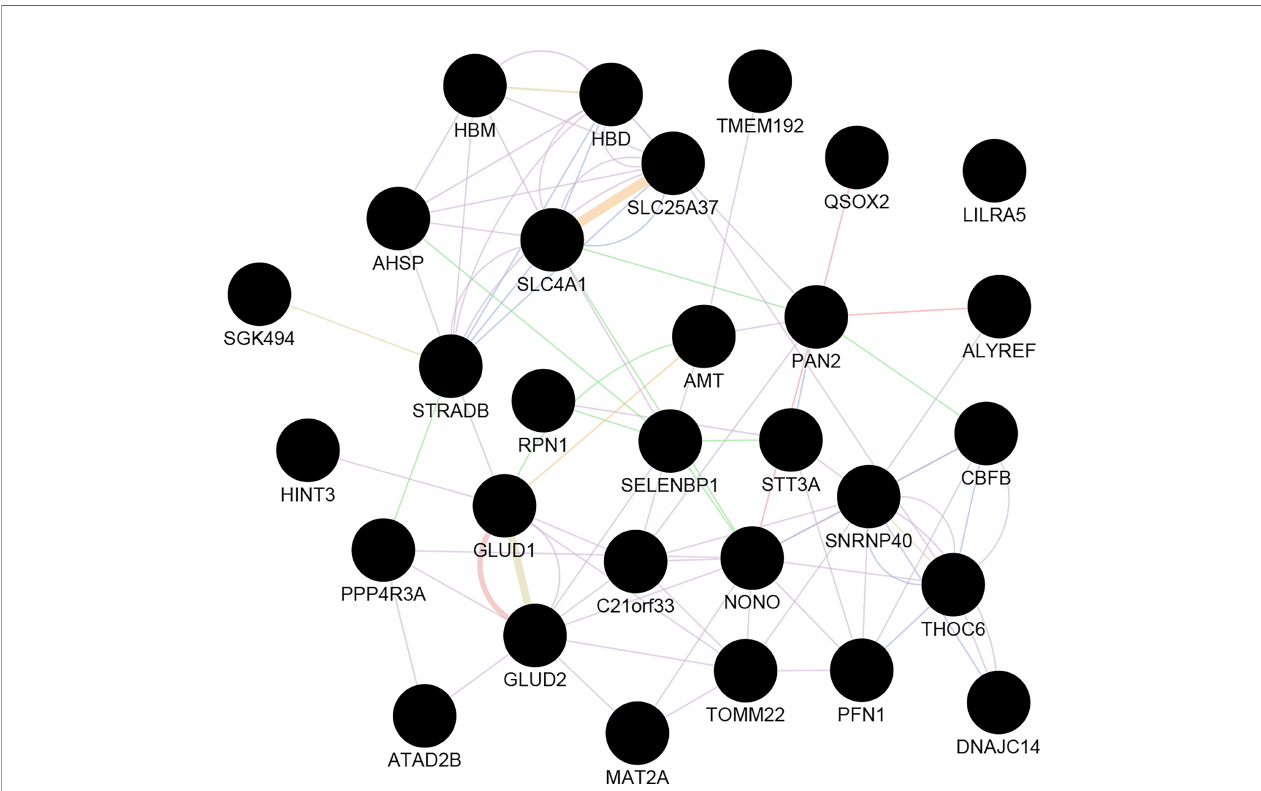
FIGURE 3 | The co-expression network of Hub-genes. Hub genes imported to GeneMANIA to construct a co-expression and gene interactions network. The circle is representing the genes. Edge: lines represent interactions between two genes (multiple lines correspond to multiple